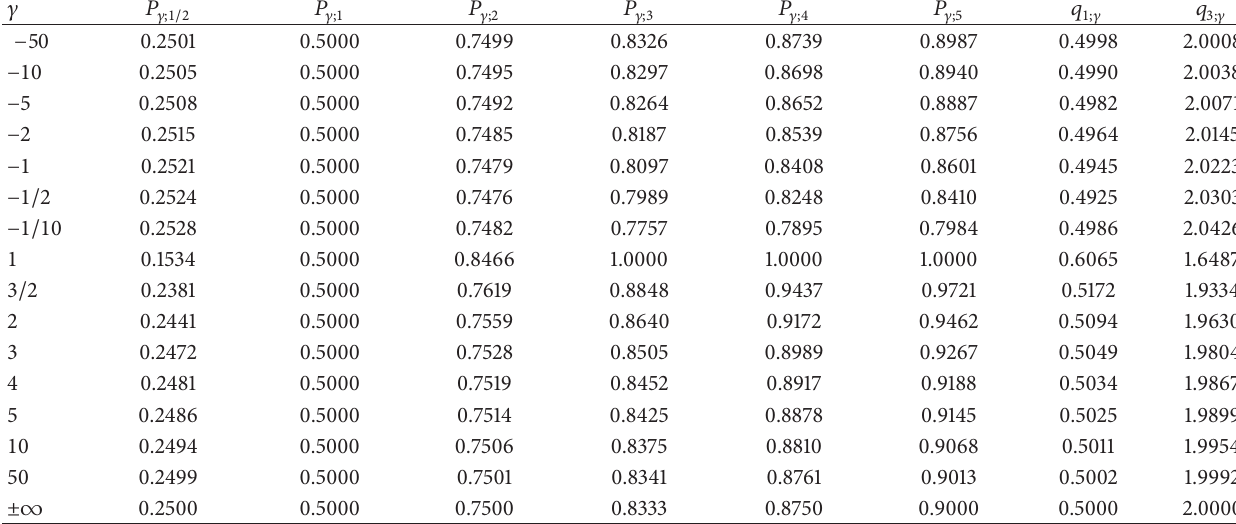
Table1:Probabilitymassvalues 𝑃 𝛾;𝑖 = Pr {𝑋 𝛾 ≤ 𝑖}, 𝑖 = 1/2, 1, 2, .. ., 5 ,andthe1stand3rdquartiles 𝑞 1;𝛾 , 𝑞 3;𝛾 forvariousgeneralizedlognormally distributed 𝑋 𝛾 ∼ LN 𝛾 (0,1)